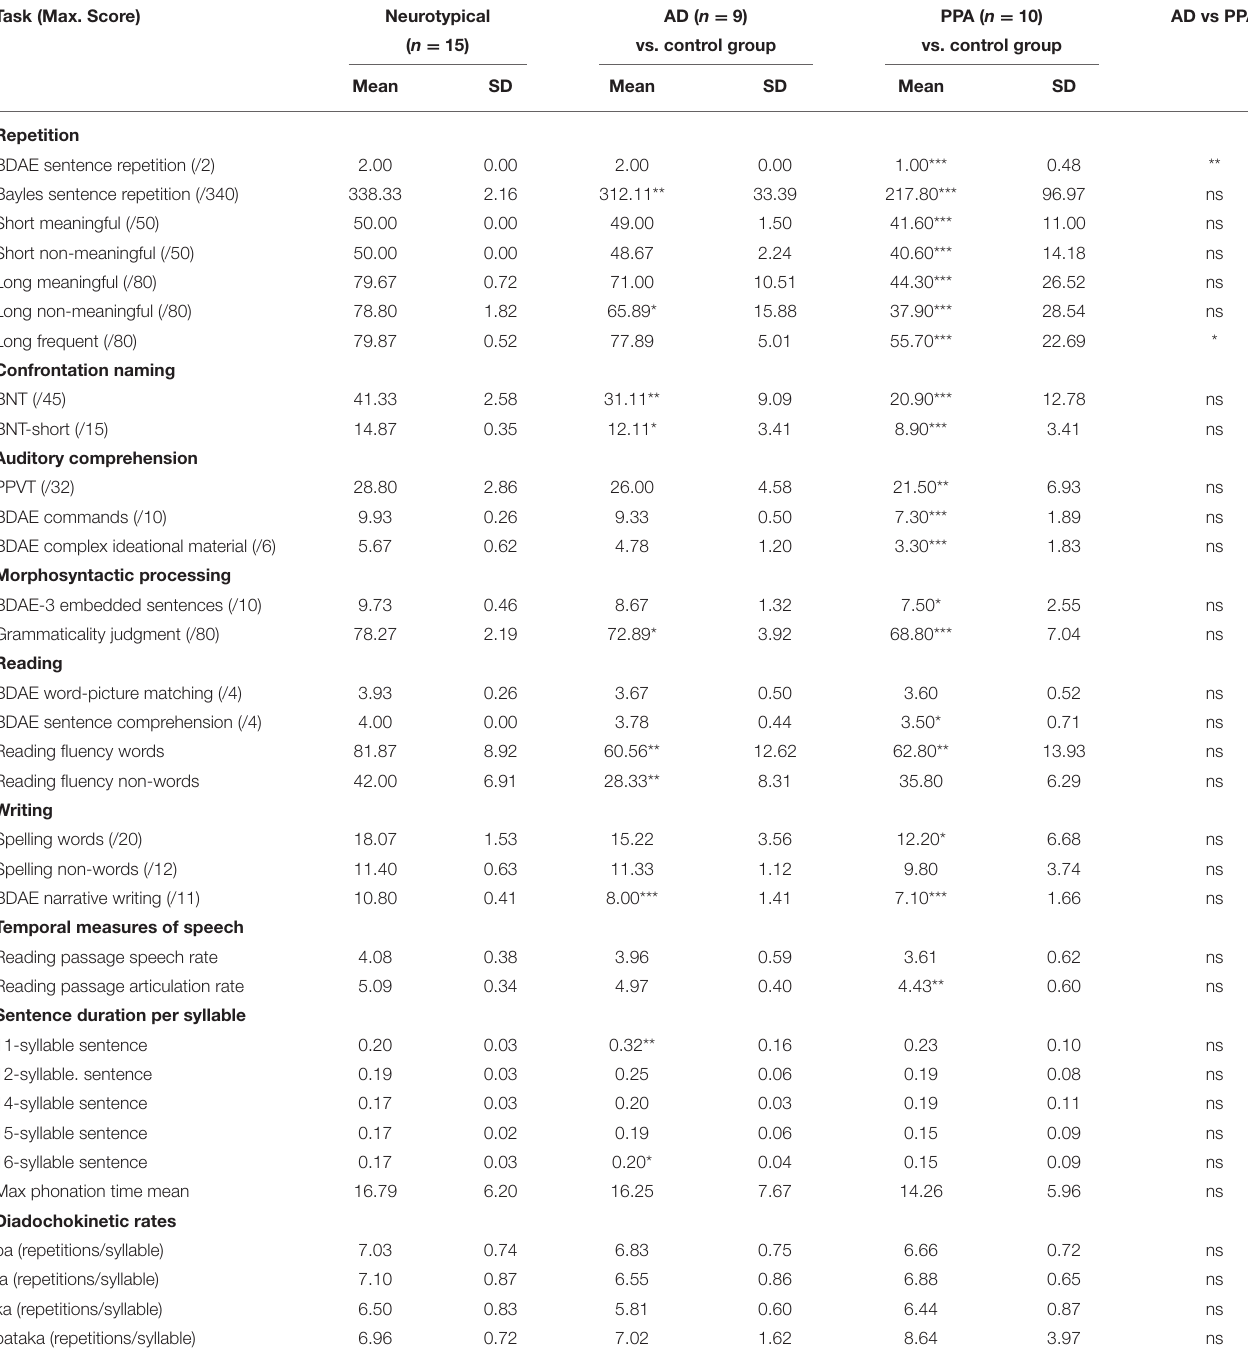
TABLE 3 | Group results for the speech and language assessment battery. Task (Max.